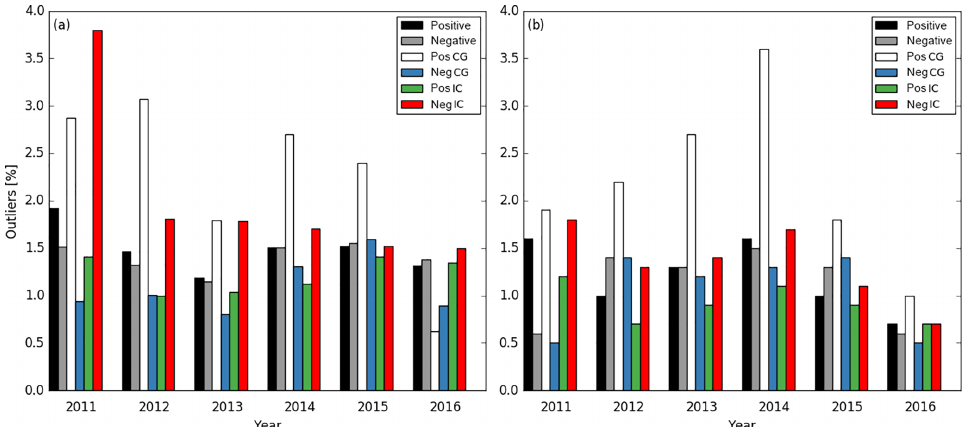
Figure 7. Percentage of outliers versus event type in (a) Belgium and (b) Austria for a search radius of